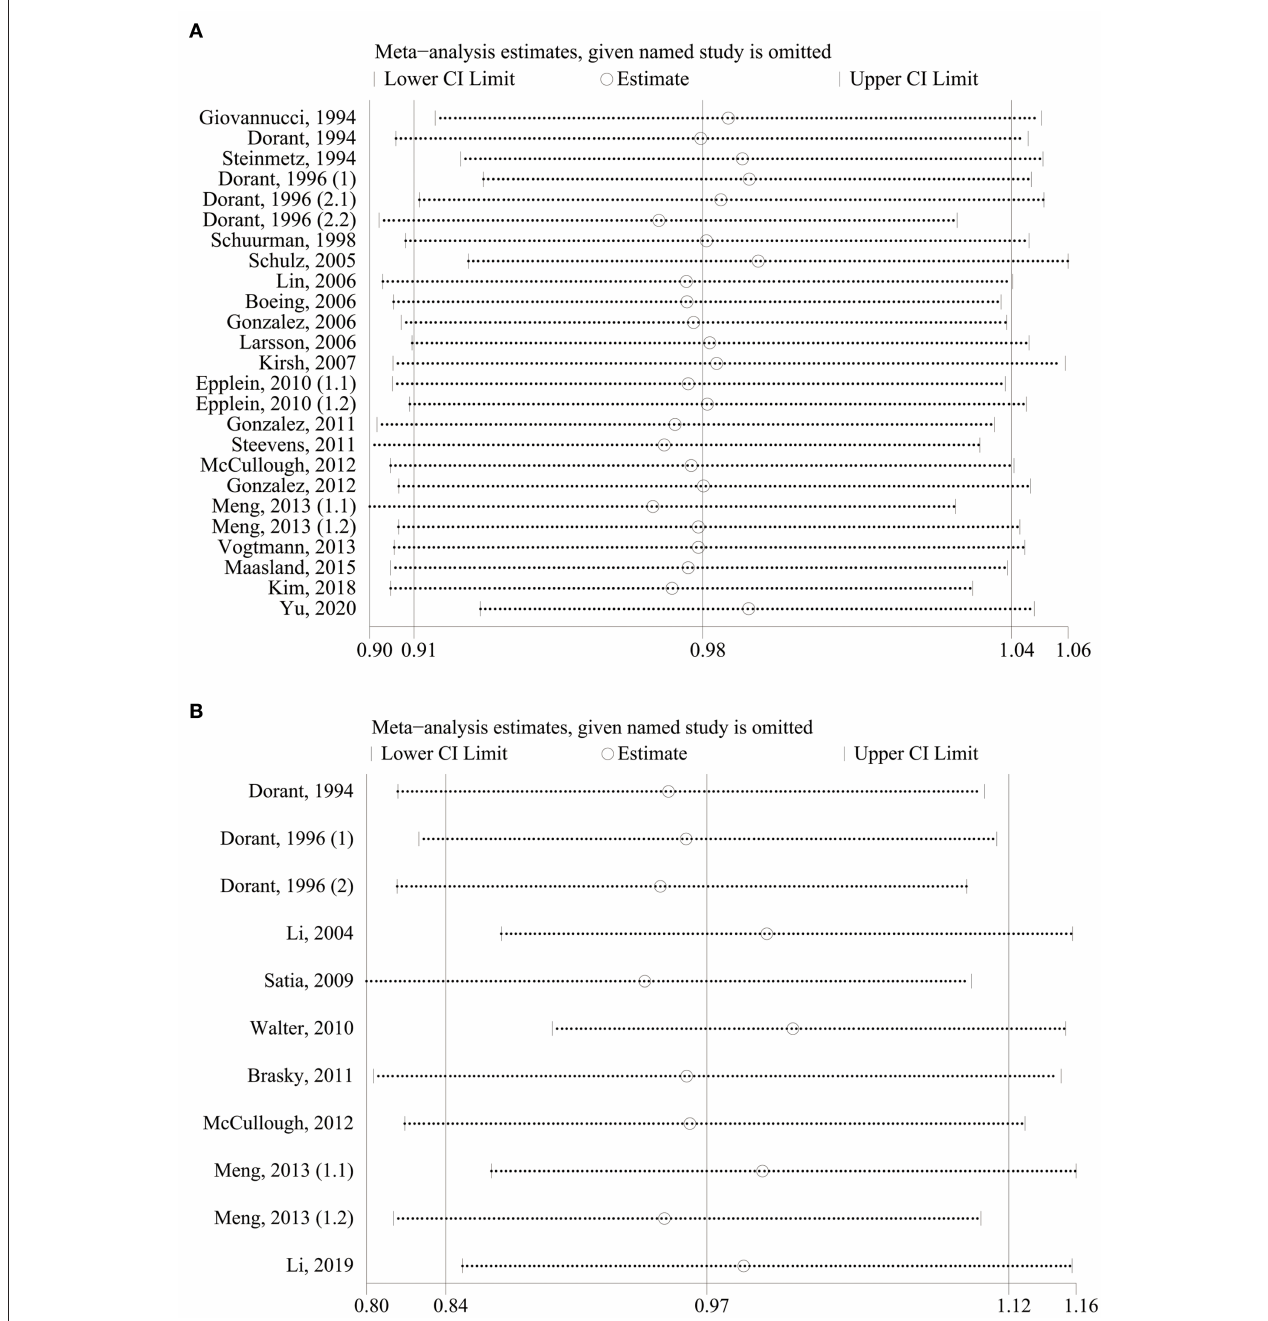
FIGURE 4 | Sensitivity analysis for cancer risk with allium vegetable (A) and garlic supplement (B)